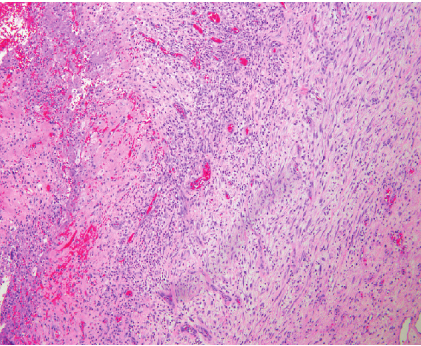
Figure 1: A representative image demonstrates necrosis with a surrounding rim of granulation tissue, composed of a dense polymorphous inflammatory